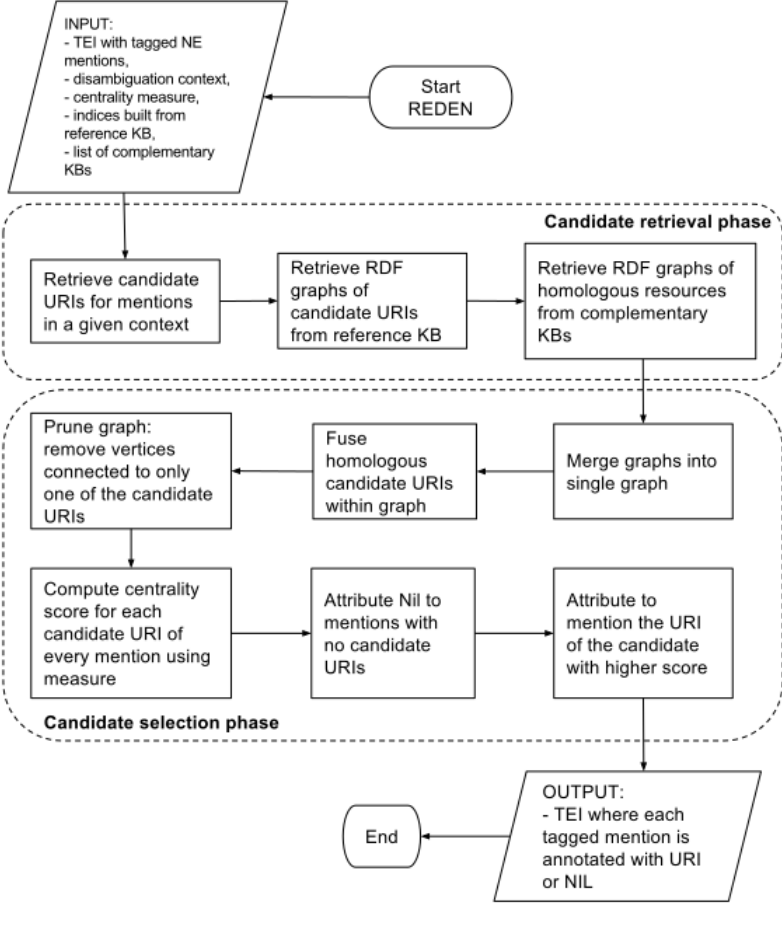
Figure 2. Flowchart to illustrate REDEN